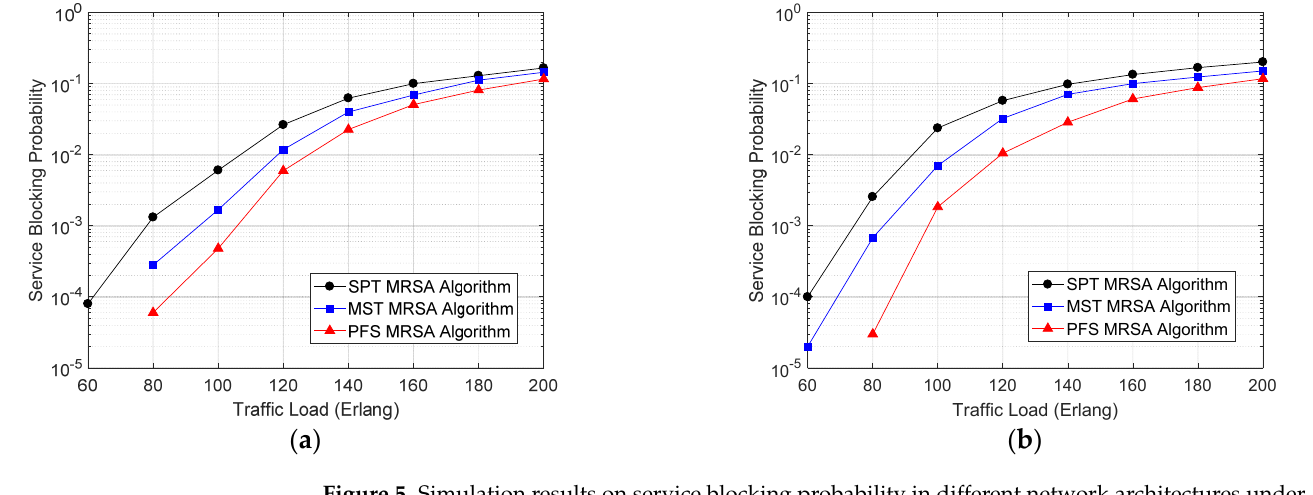
Figure 5. Simulation results on service blocking probability in different network architectures under scenario one: ( a ) in NSFNET and ( b ) in USNET.